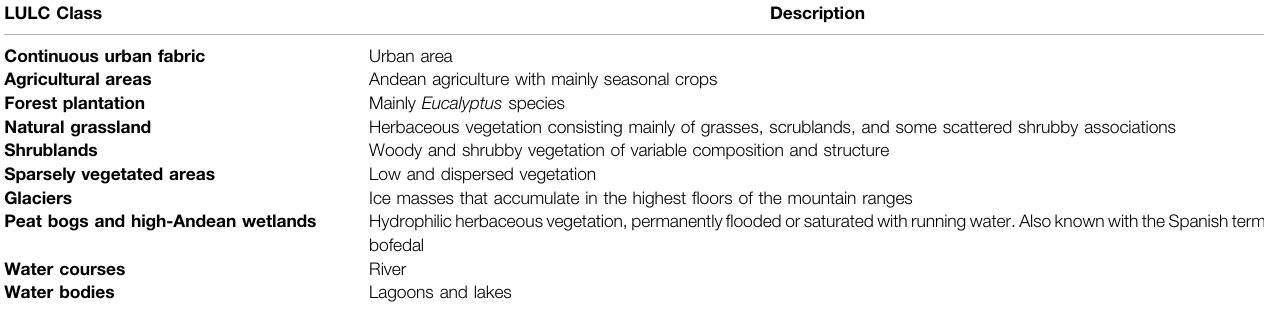
TABLE 2 | Description of LULC classes used in the